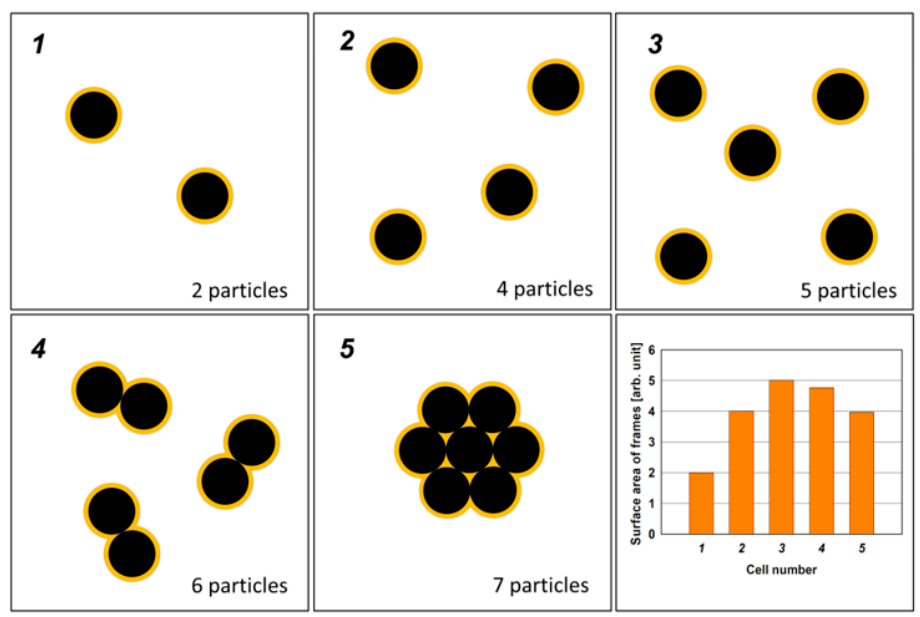
Figure 2. A simple model of the rubber surface with carbon black nanoparticles surrounded by bound rubber (yellow frames). As the carbon black content increases, the clustering e ff ect occurs. The graph (bottom right) shows the changes in the surface area occupied by the bound rubber as a function of the carbon black content in this model. (The graph was obtained using the GIMP 2.10.18 software [34], by which the number of pixels for the surface area of nanoparticles and bound rubber was counted in the presented model.)